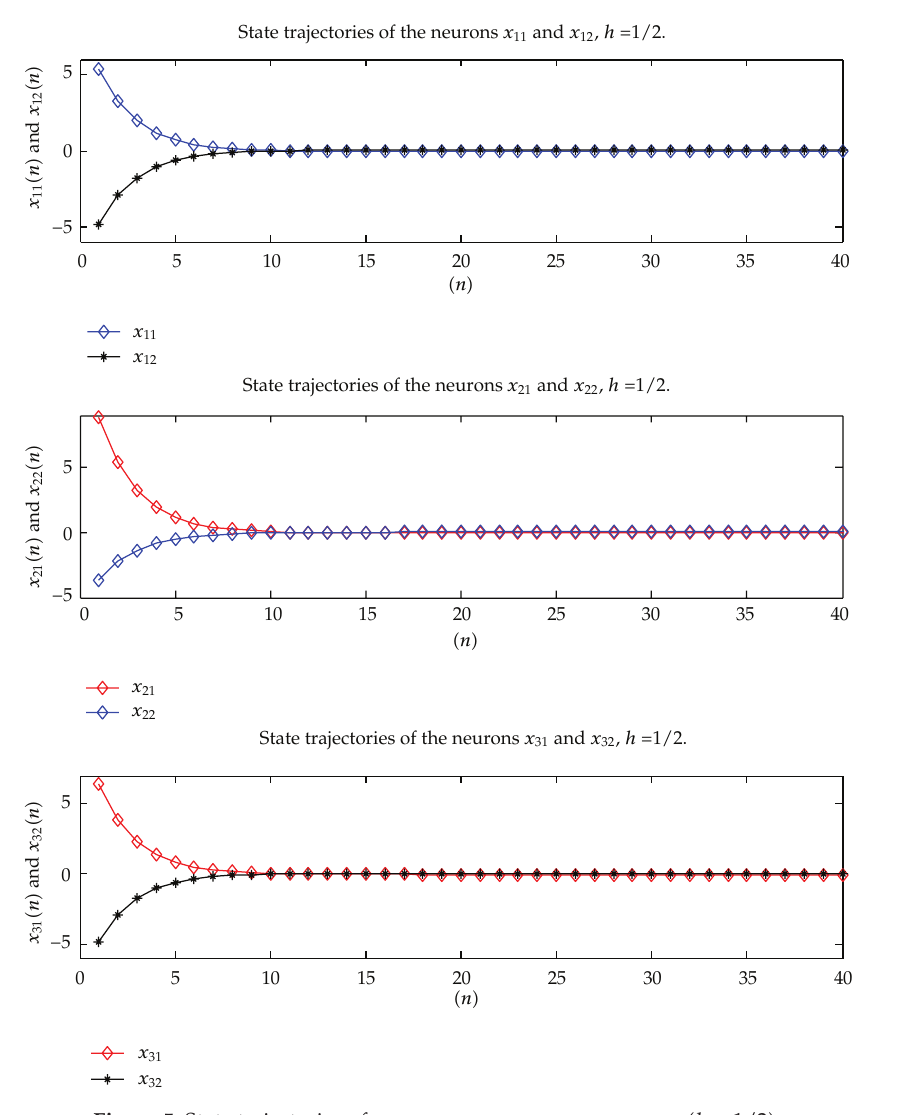
Figure 5: State trajectories of neurons x 11 , x 12 , x 21 , x 22 , x 31 , x 32 (cid:3) h (cid:8) 1 / 2 (cid:4)